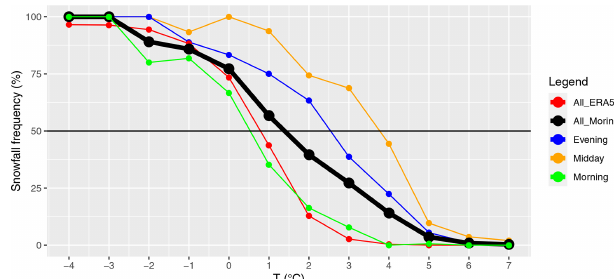
Figure 3. Snowfall frequency curves calculated using Morin’s ob- servations of the morning (green), midday/afternoon (orange), and evening (blue). The black line includes all of Morin’s measure- ments, and the red line shows the mean of the ERA5 hourly